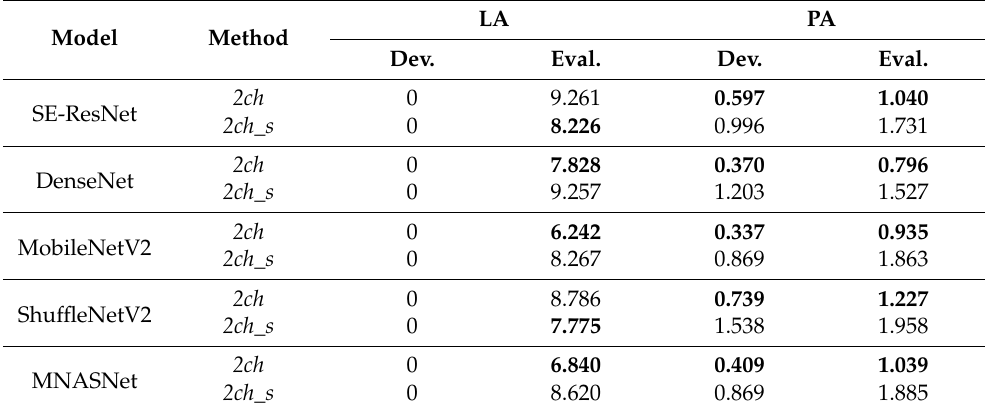
Table 4. Oracle EERs (%) of systems (excluding the x-vector network) in the development and evaluation trials of ASVspoof 2019 LA and PA, with the methods of 2ch and 2ch_s . For each model, the lowest EER is highlighted in